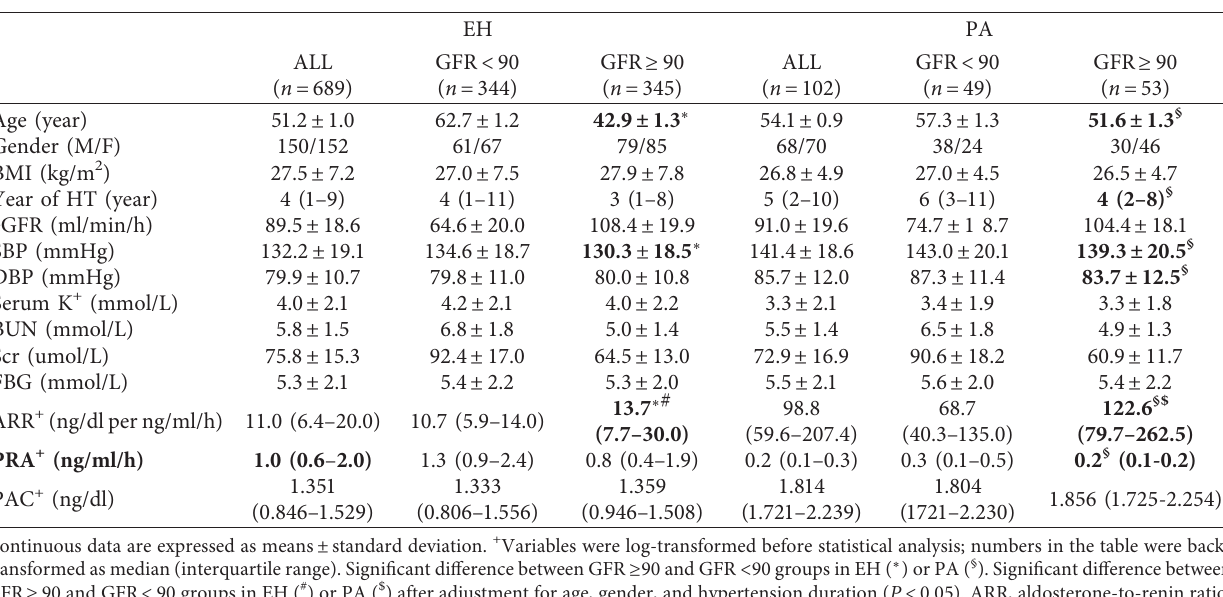
Table 1: General characteristics in essential hypertension and primary aldosteronism patients.